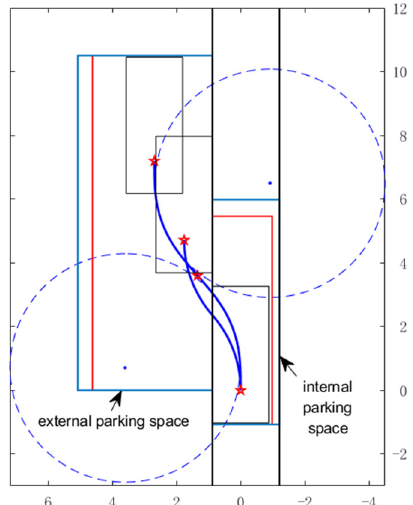
Figure 15. For the comparison between parking with continuous-curvature curve and circular arcs.